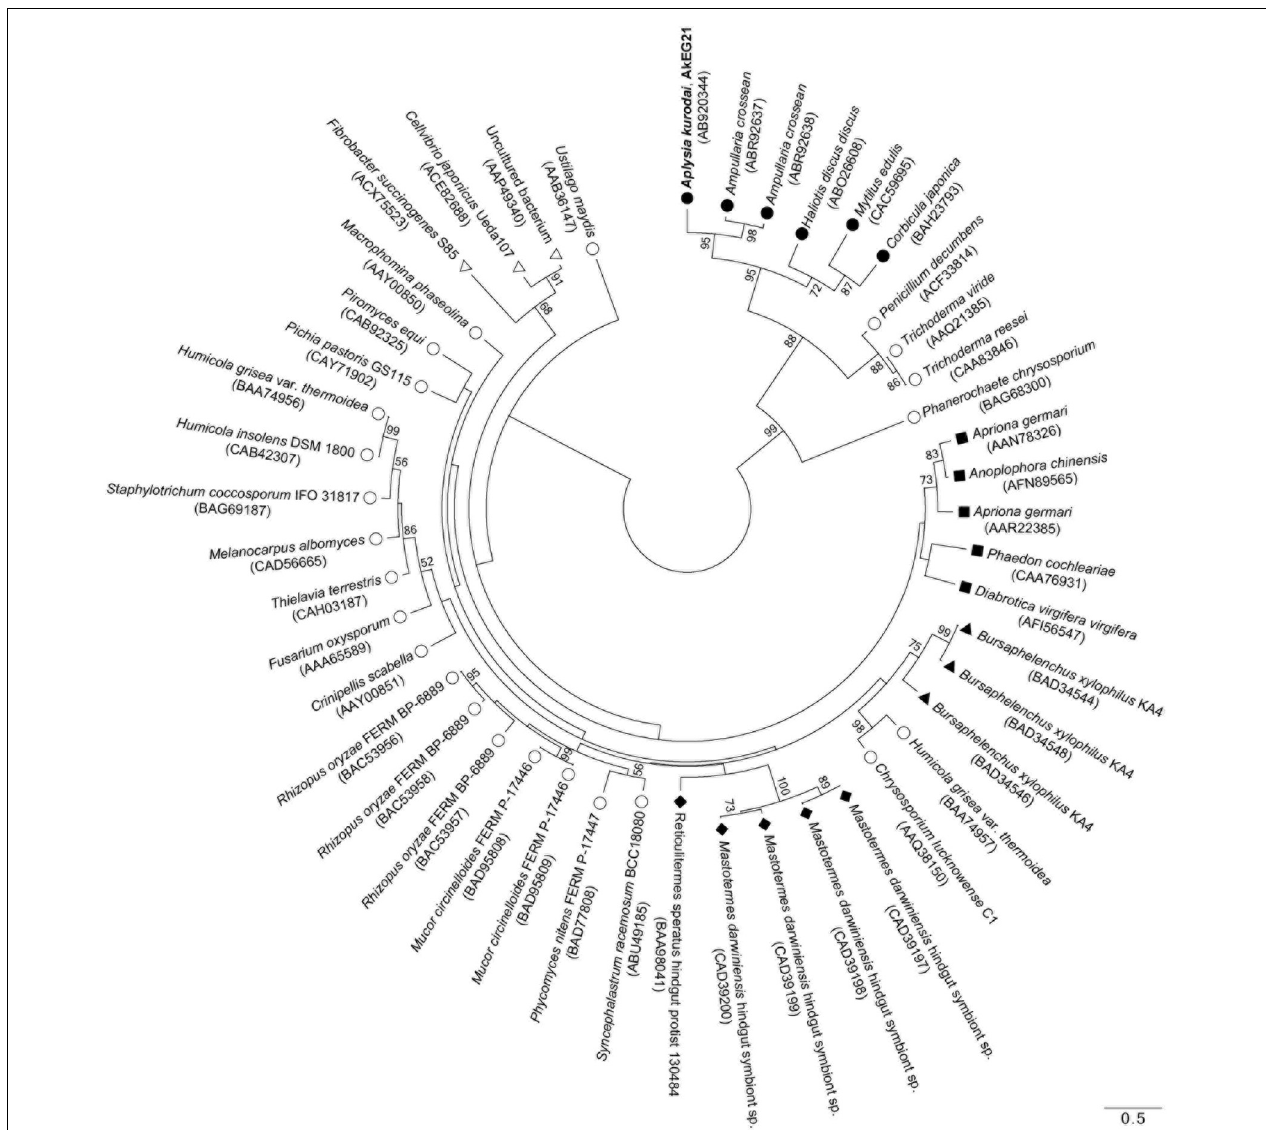
FIGURE 7 | Phylogenic relationship for GHF45 cellulases. An unrooted phylogenetic tree for catalytic domains of AkEG21 and GHF45 enzymes from CAZy database was generated using MEGA 6 software. Bootstrap values over 50 are indicated on the branches. The scale bar indicates 0.50 amino-acid substitutions. Symbols shown with scientific